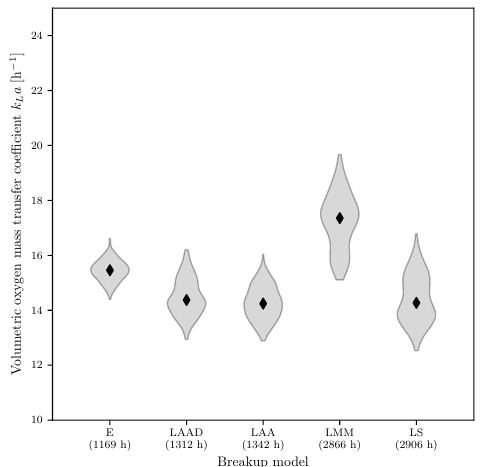
Figure 11. Influence of different breakup models on the k L a value. The mean values and the corresponding probability density function are shown in violin form. The time corresponds to the CPU time required for the simulation of 20 s (E = Exponential kernel, LAAD = Laakkonen, Alopaeus and Aittamaa with daughter size distribution [84], LAA = Laakkonen, Alopaeus and Aittamaa [84], LMM = Lehr, Millies and Mewes [32], LS = Luo and Svendsen